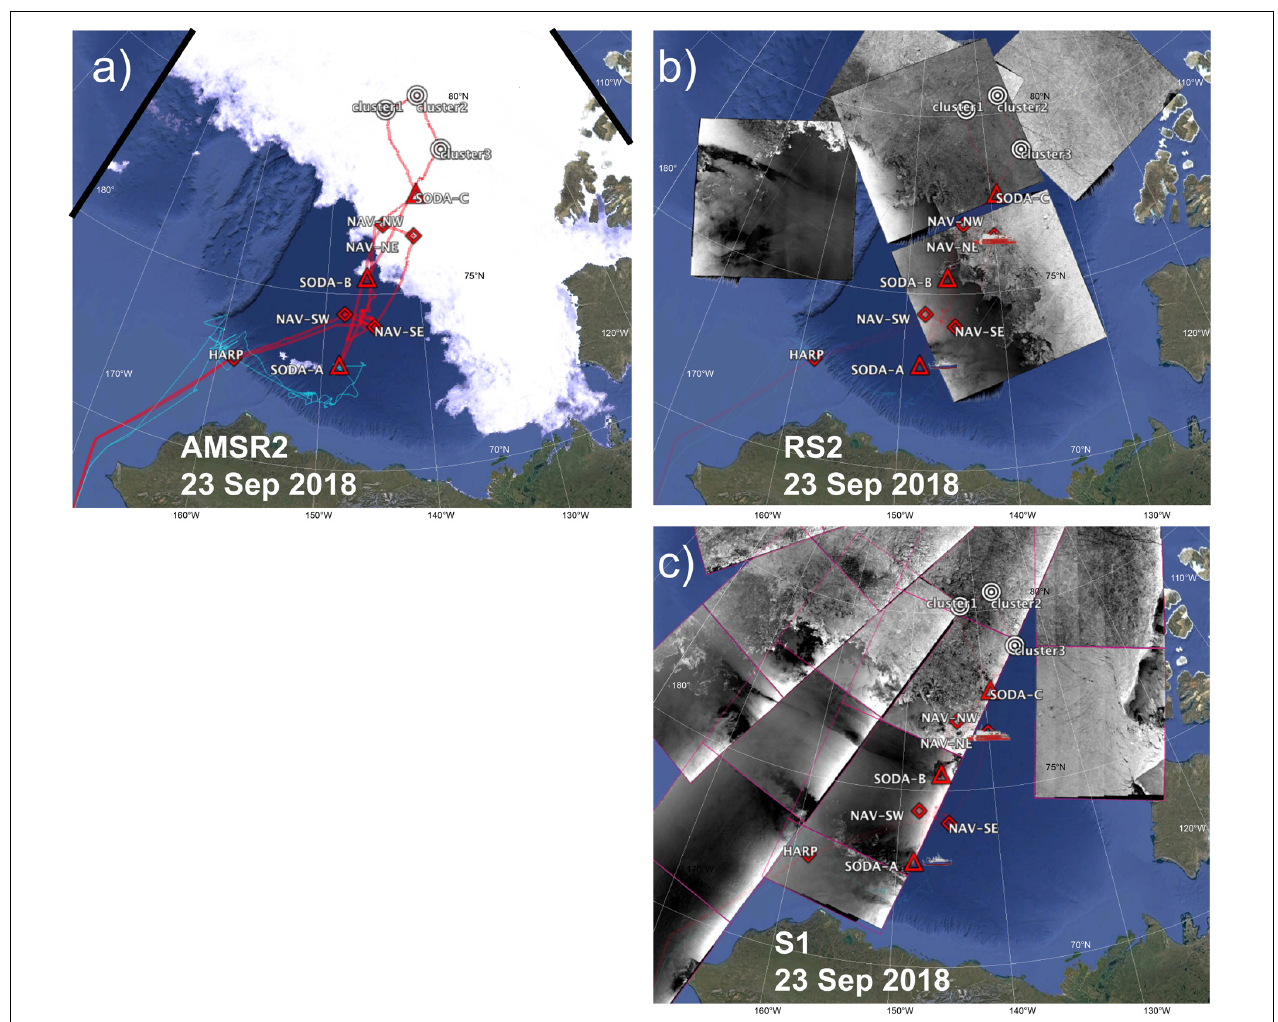
FIGURE 6 | Example of (a) Passive Microwave (AMSR2), displayed only between 170 and 110 ◦ W, (b) Radarsat-2, and (c) Sentinel-1 remote sensing products on September 23, 2018. Healy (red) and Sikuliaq (cyan) cruise tracks are shown in (a) , and the location of the ships on that day in (b,c) . SODA moorings and instrument clusters are also shown. Images are displayed as an overlay in Google Earth.